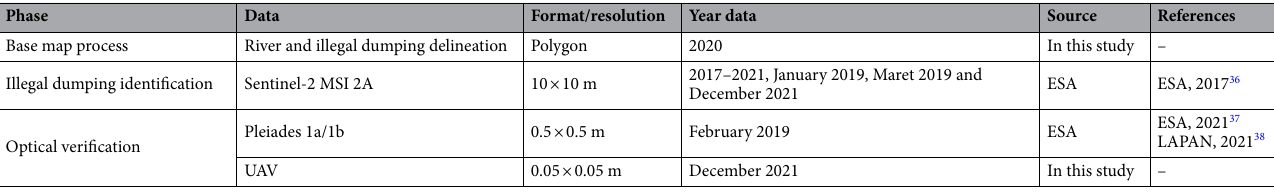
Table 1. Data used in this